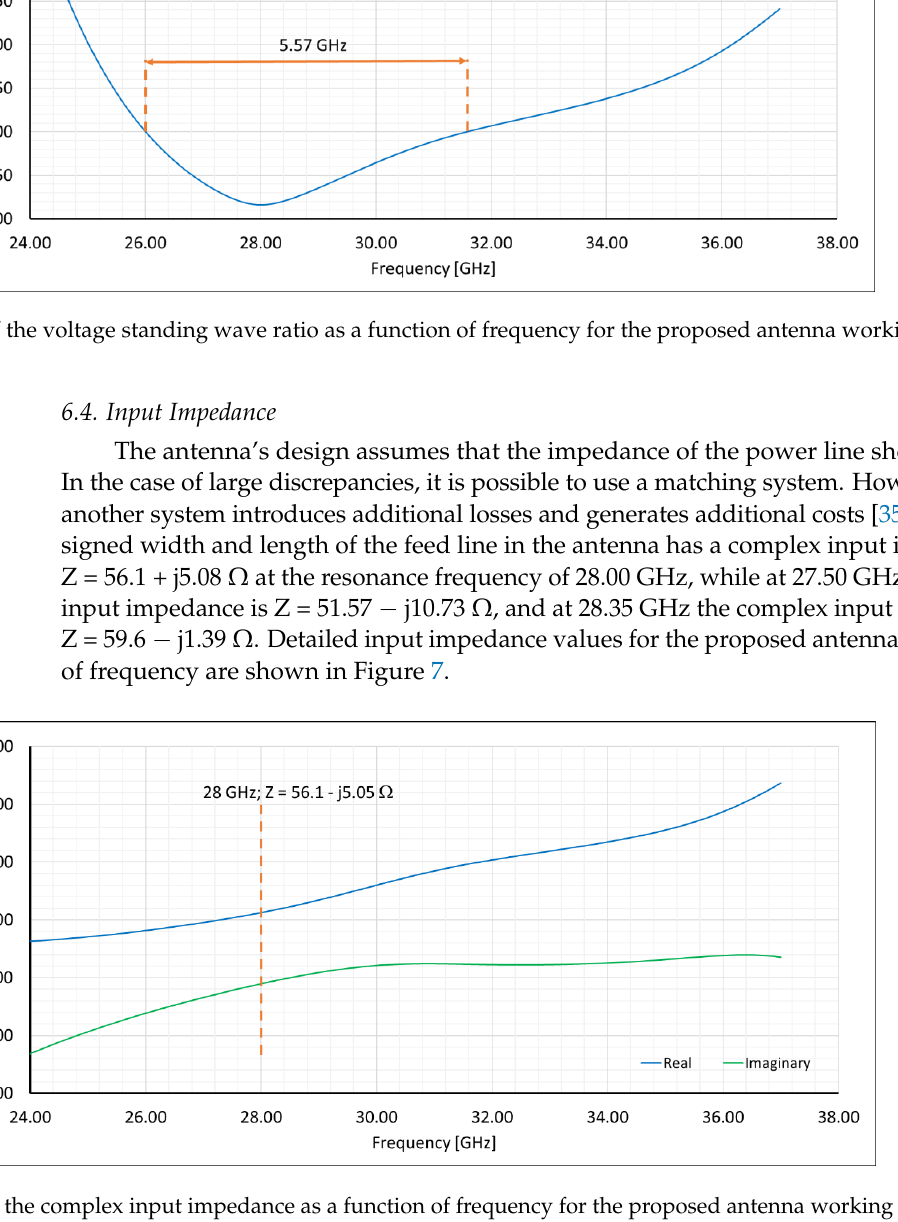
Figure 5. The reflection coefficient as a function of frequency for the proposed antenna working in the fifth generation (5G) system.